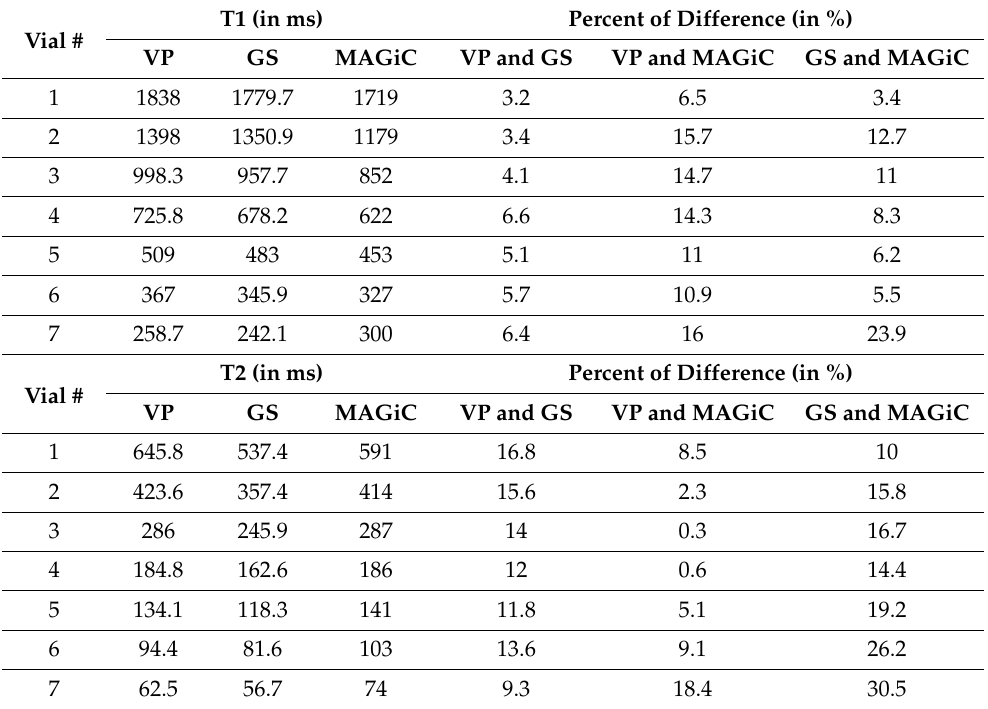
Table 2. T1 and T2 values from three different methods.